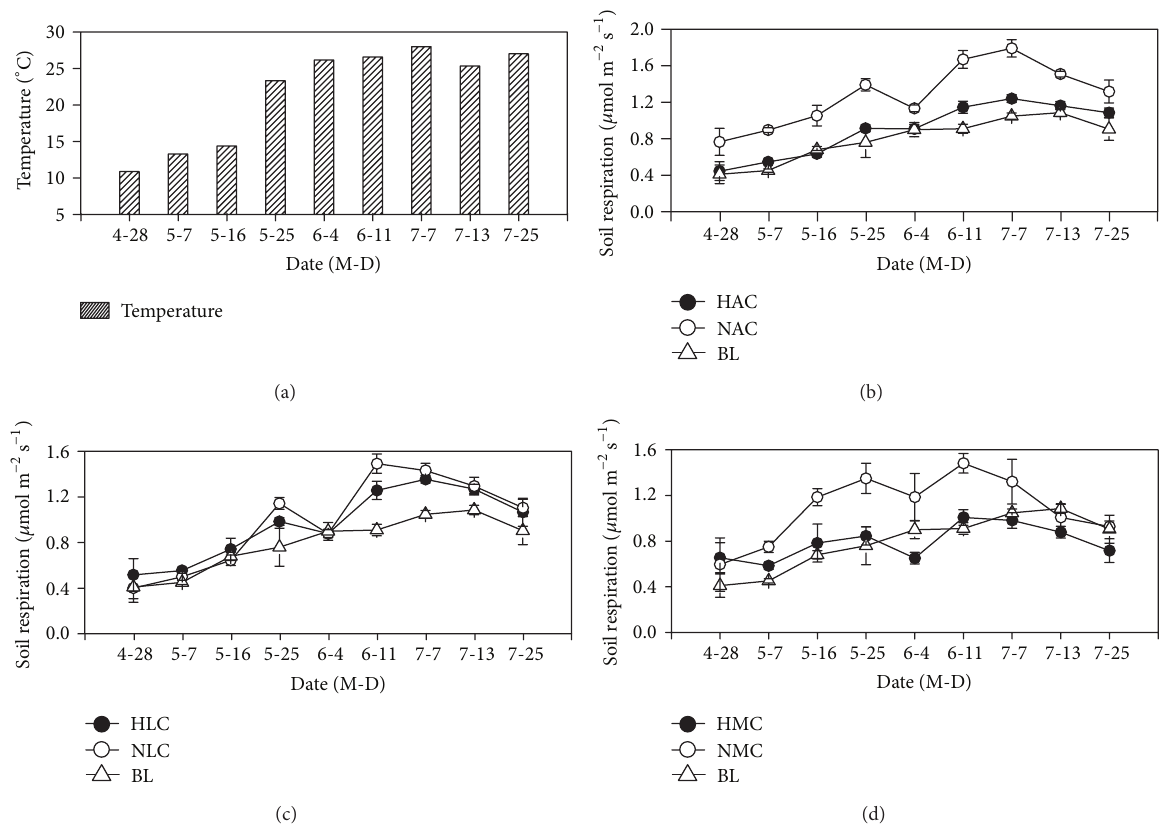
Figure 2: Mean daily soil temperature (a) and Rs in biocrusted soil (black solid circle), disturbance biocrusted soil (hollow circle), and bare land (upward triangle) in algae crusted soil (b), lichen crusted soil (c), and moss crusted soil (d). Error bars indicate standard deviation. Table 2: The effects of soil cover type ( 𝐶 ), measurement time ( 𝑇 ), and their interactions ( 𝐶×𝑇 ) on mean daily Rs ( 𝜇 mol m − 2 s − 1 ) in the three biocrusted soil cover areas. Algae crust cover